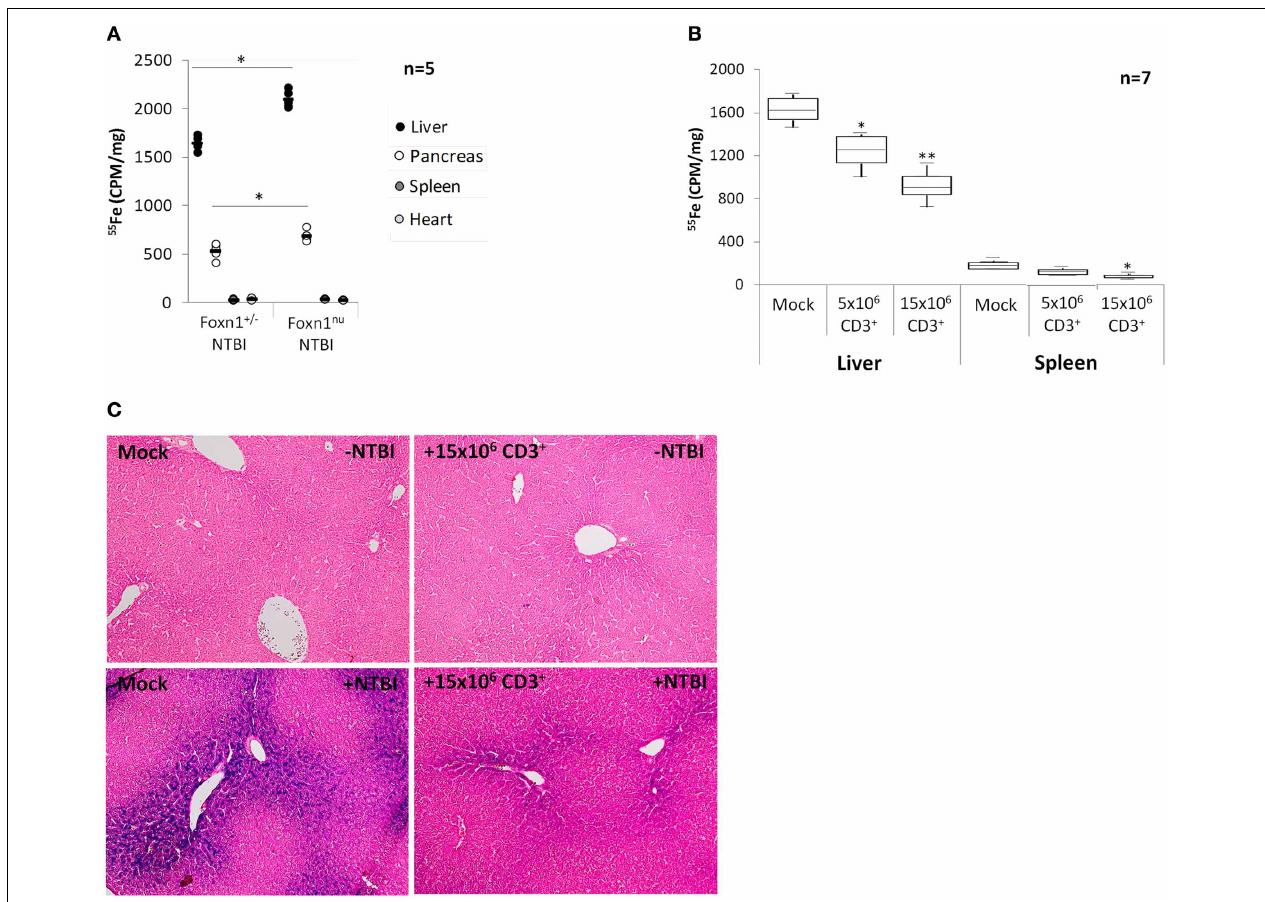
quartile, median, and upper quartile (boxes) and minimum/maximum ranges (whiskers; ∗ P < 0 . 05, ∗∗ P < 0 . 005 control vs. reconstituted animals; Students’ t -test). (C) Perls’ Prussian blue staining of iron (blue) in livers of Foxn1 nu mice + iron-sufficient diet (upper left panel), Foxn1 nu mice + iron-sufficient diet reconstituted with 15 × 10 6 T lymphocytes (upper right panel), Foxn1 nu mice + iron-rich diet (bottom left panel) and Foxn1 nu mice + iron-rich diet reconstituted with 15 × 10 6 T lymphocytes (bottom right panel). Magnification = 100 ×